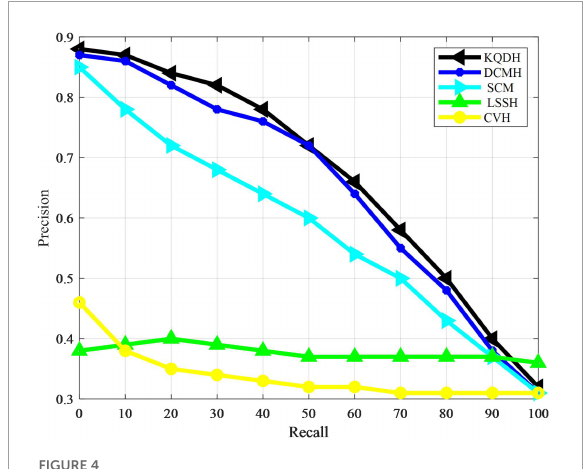
FIGURE4 Accuracy recall rate curve of NUS-WEE data set.